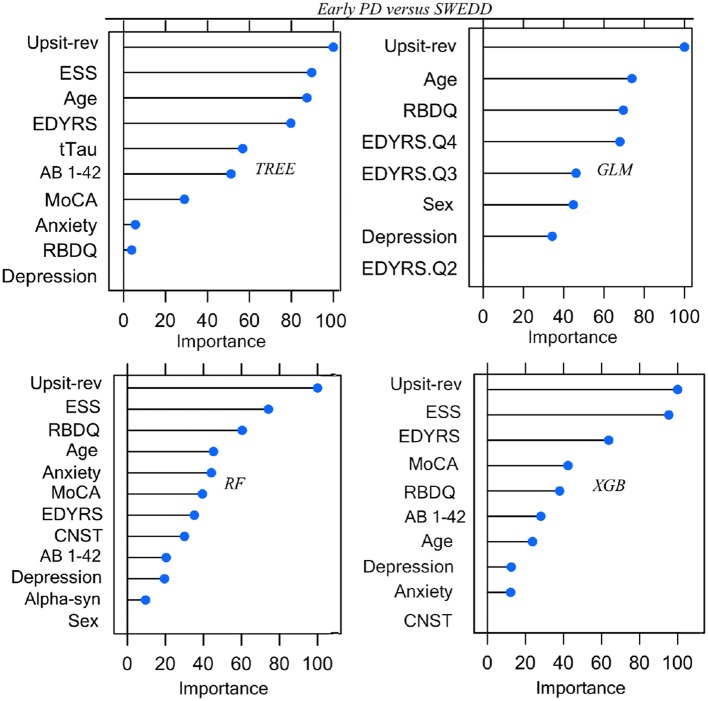
Predictor Early PD vs. SWEDD. GLM, logistic regression; TREE, decision tree; RF, random forest; XGB, Extreme gradient boosting; Anxiety, state trait anxiety; AB 1-42, beta amyloid 1−42; Alpha-syn, CSF α-synuclein; CNST, constipation; Depression, Geriatric depression scale; EDYRS Q2, lower quartile for number of education years; EDYRS Q3, upper quartile for number of education years; EDYRS Q4, number of education years of those exceeding the upper quartile; ESS, Epworth sleepiness scale; GDS, Geriatric depression scale; MoCA, Montreal Cognitive Assessment; Upsit-rev, University of Penn-sylvania Smell Identification Test, reverse-scaled;RBDQ, rapid eye movement behavior disorder questionnaire; Predictors ranked on a 0 to100% scale of importance.